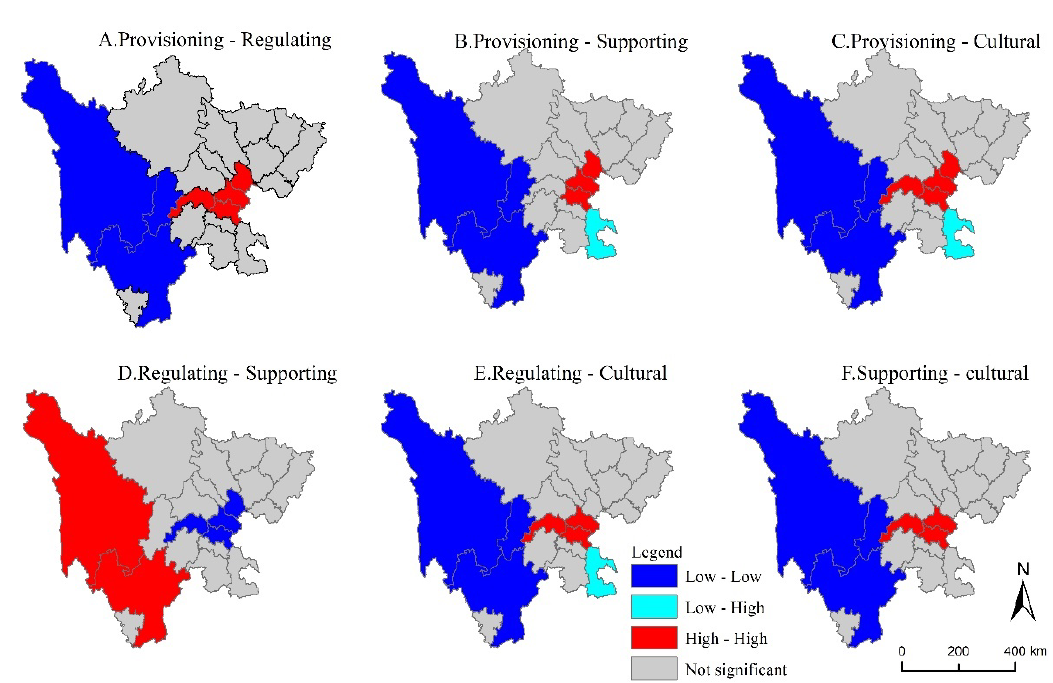
Figure 5. LISA cluster map of four ecosystem services in Sichuan Province at the city-scale.